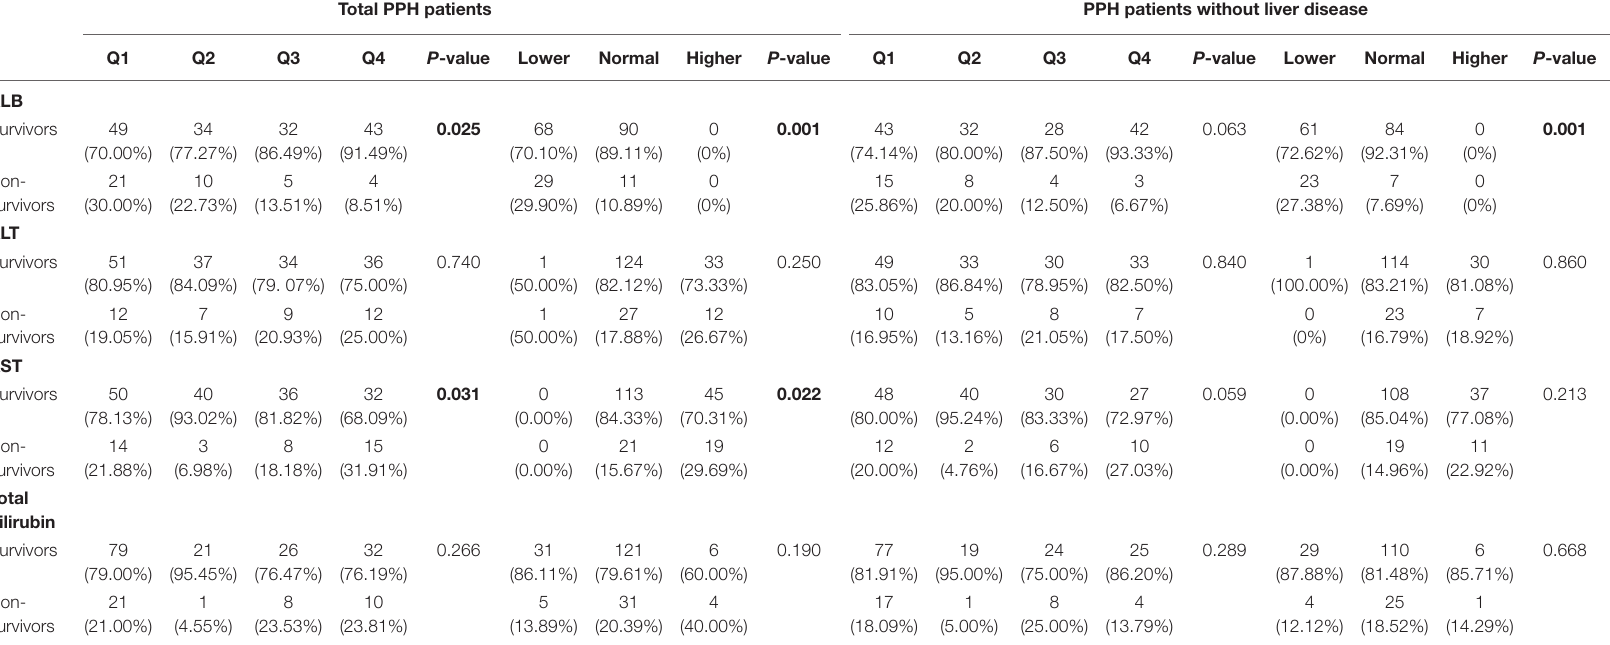
TABLE 4 | The relationship between ALB, ALT, AST, and total bilirubin with 90-day